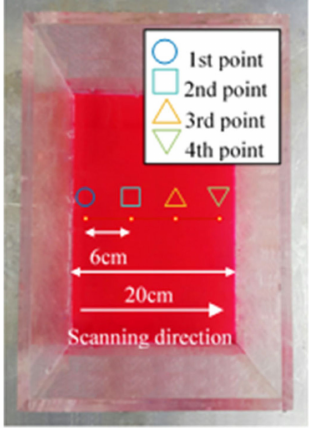
Figure 7. Measurement points of the rectangular